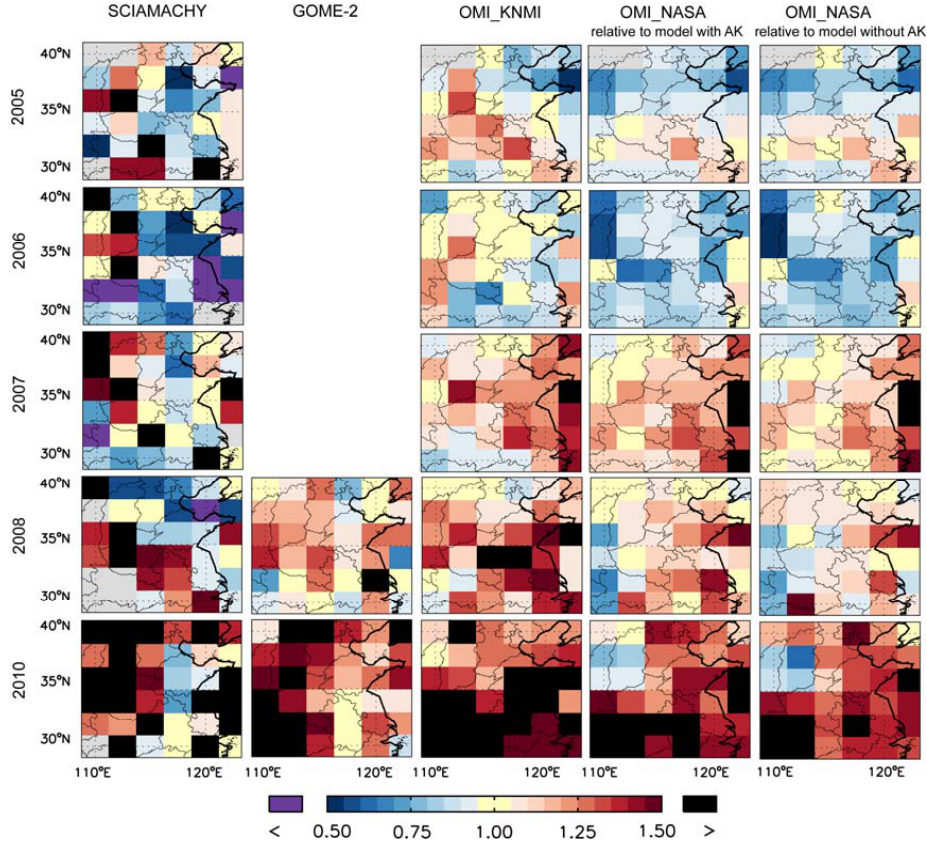
Fig. 7. Ratios of derived emissions of NO x in January of 2005–2010 over emissions in January 2009 in Northern East China. Plots for 2009 are skipped as the values are uniformly unity. Data are presented at the model resolution of 2.5 ◦ long × 2 ◦ lat. Areas in grey color do not have valid retrievals. See Sect. 6.2 for the derivation of emissions of NO x .